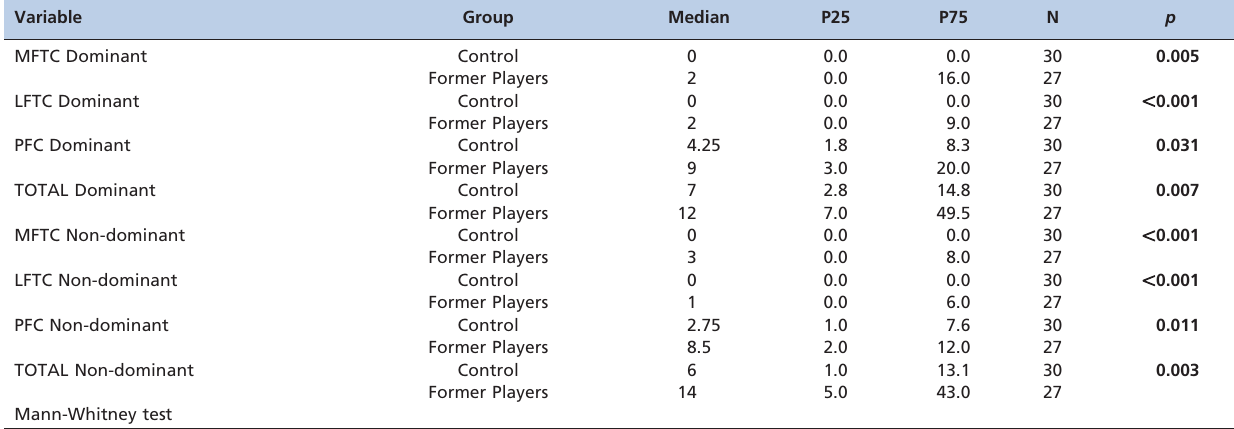
Table 6 - Whole-Organ Magnetic Resonance Imaging Score findings comparison between groups. Variable Group